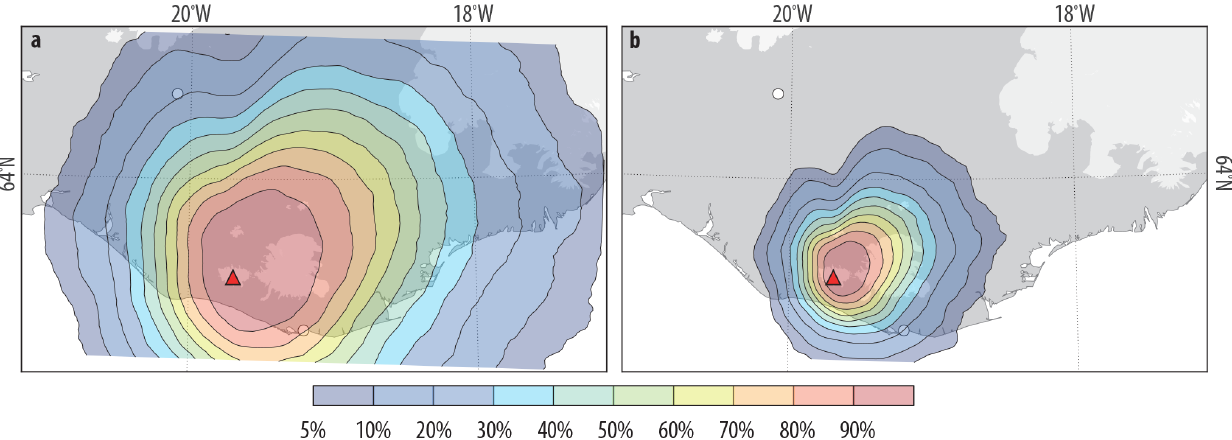
Figure 10. Probability maps (%) for ground accumulation associated with a long-lasting 2010-type eruption of Eyjafjallajökull volcano. (a) LLOES, threshold of 1kgm − 2 ; (b) LLOES, threshold of 10kgm − 2 . Eruption parameters are summarized in Table 3 and Fig. 6.